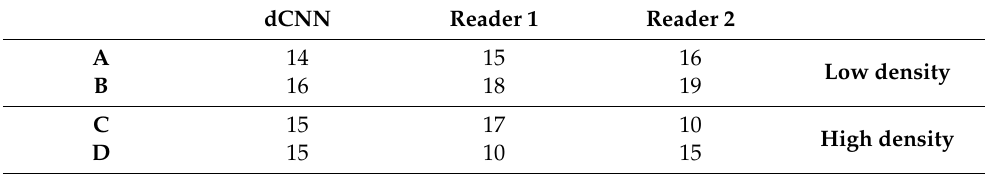
Table 4. Assessment of breast-CT density of two readers and dCNN Model 2 in 60 images.